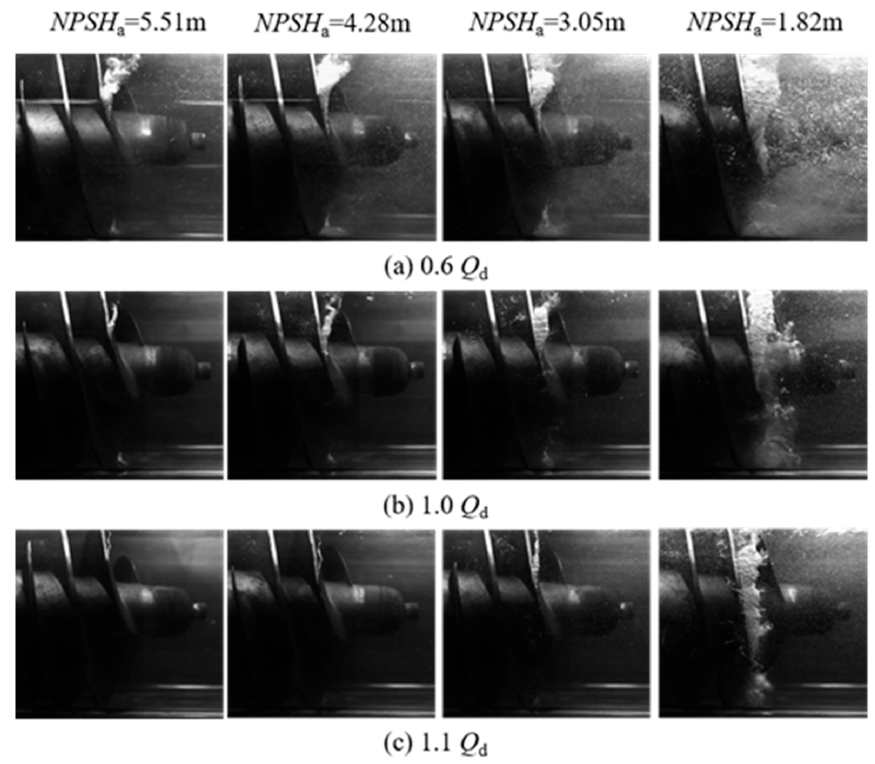
Figure 13. Comparison of cavitation shapes at various flow rates and NPSHa.